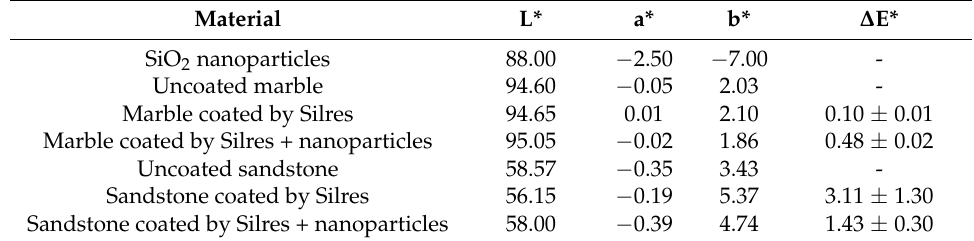
Table 3. Mean values of colour coordinates of SiO 2 nanoparticles, uncoated and coated marble and sandstone specimens. The global colour differences ( ∆ E*) of marble and sandstone, induced upon coating applications, are